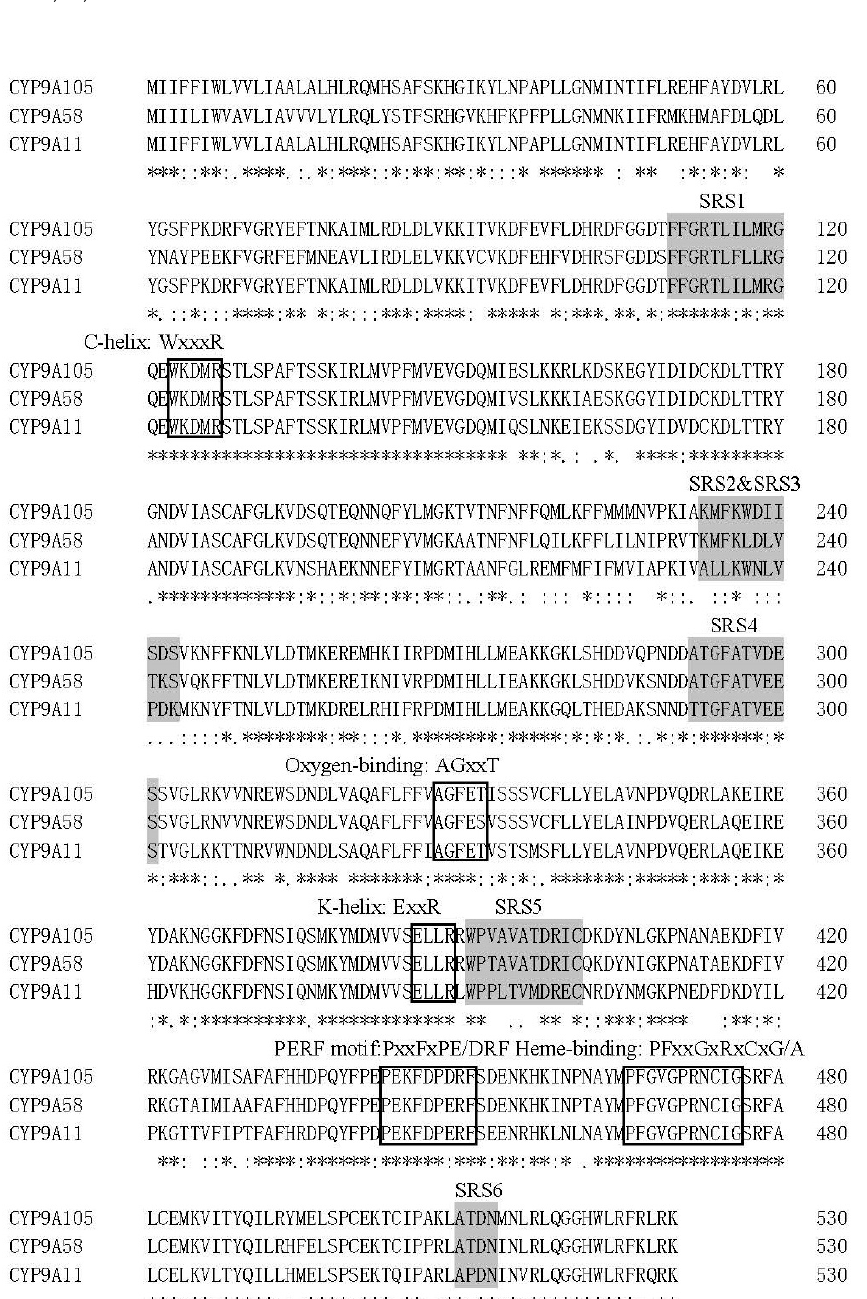
Figure 1. Comparison of the deduced amino acid sequences of Spodoptera exigua CYP9A105 , Spodoptera littoralis CYP9A51 (GenBank accession number JX310084.1) and Spodoptera frugiperda CYP9A58 (GenBank accession number KJ671577.1). Substrate recognition sites (SRS) are indicated with gray boxes. Identical amino acid residues are marked with “*”, and conserved residues with “:”. The conserved P450 Helix C (WxxxR), Oxygen-binding motif (AGxxT), Helix K (ExxR), PERF motif (PxxFxPE/DRF) and heme-binding domain (PFxxGxRxCxG/A) are also shown.